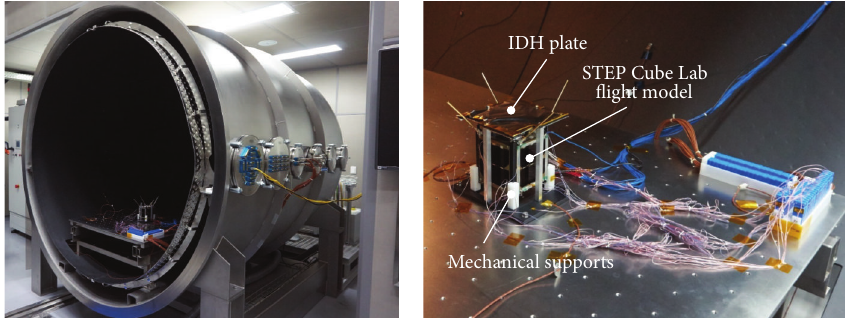
Figure 13: Thermal vacuum test